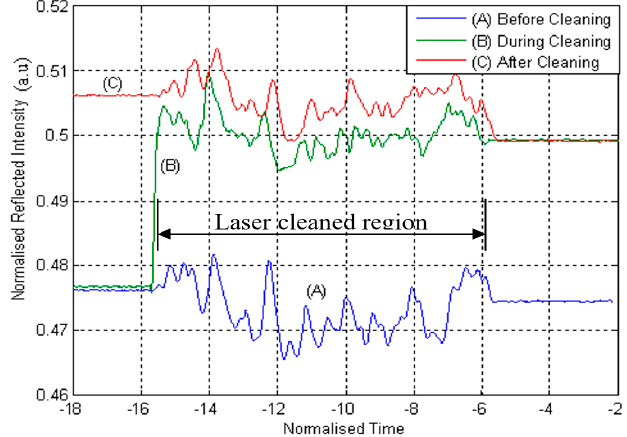
Figure 6. Effects of laser cleaning on PBR intensity along a linear track (beam size = 1 mm 2 , fluence = 0.55 J/cm 2 , No. of pulse/position = 20, frequency = 10 Hz, monitoring laser wavelength = 635 nm).